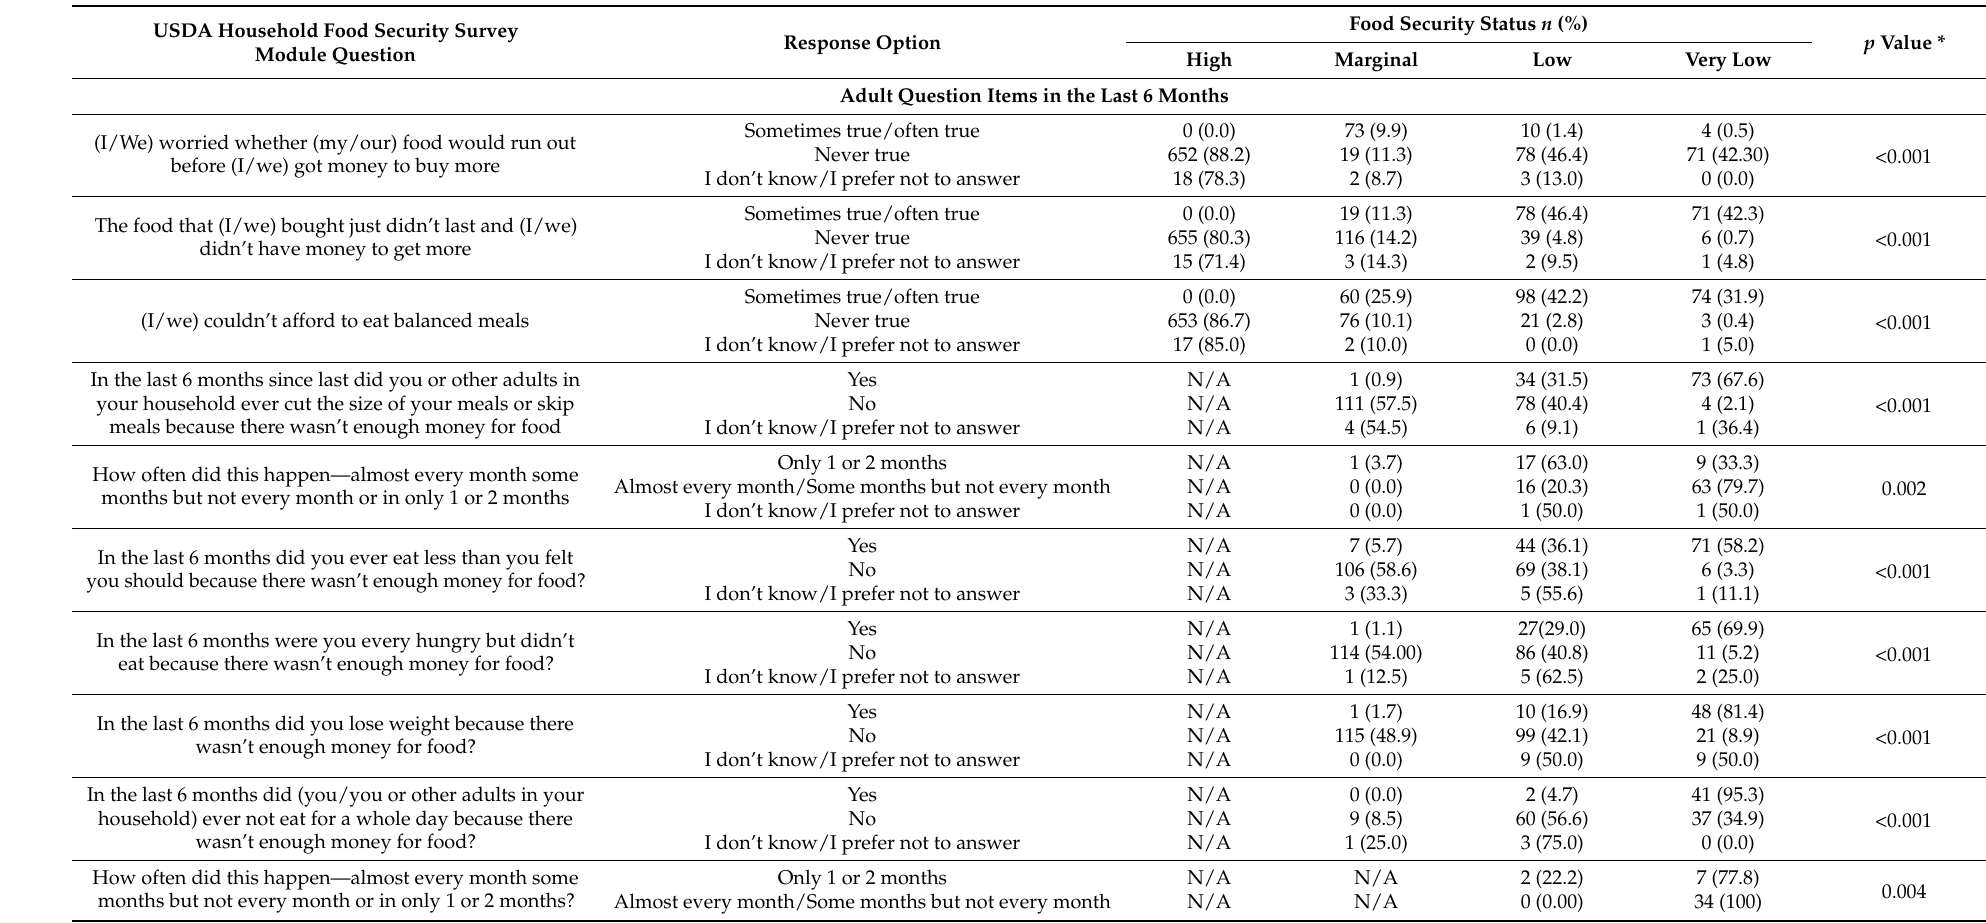
Table 2. Responses to the 18-item USDA Household Food Security Survey across food security status during COVID-19 in Australia in 2020. USDA Household Food Security Survey Module